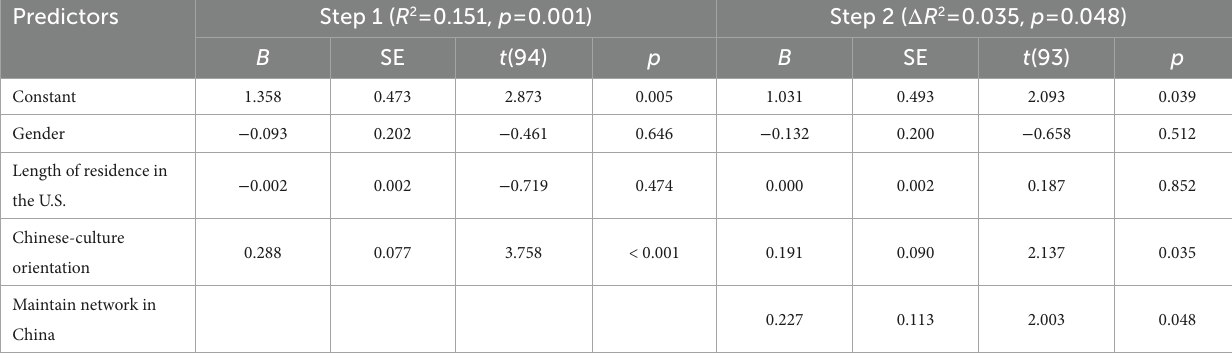
TABLE 5 Results of hierarchical linear regression predicting distant instrumental support-seeking in Study 2. Predictors